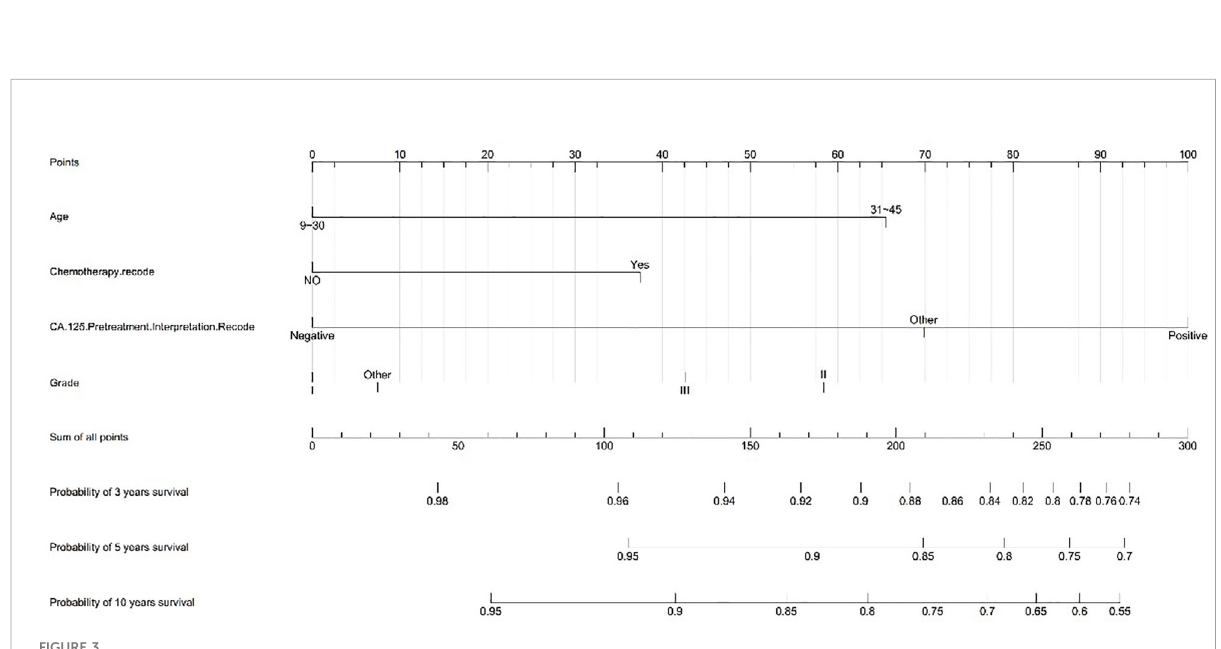
FIGURE 3 Nomograms to predict 3-, 5-, and 10-year CSS for stage I